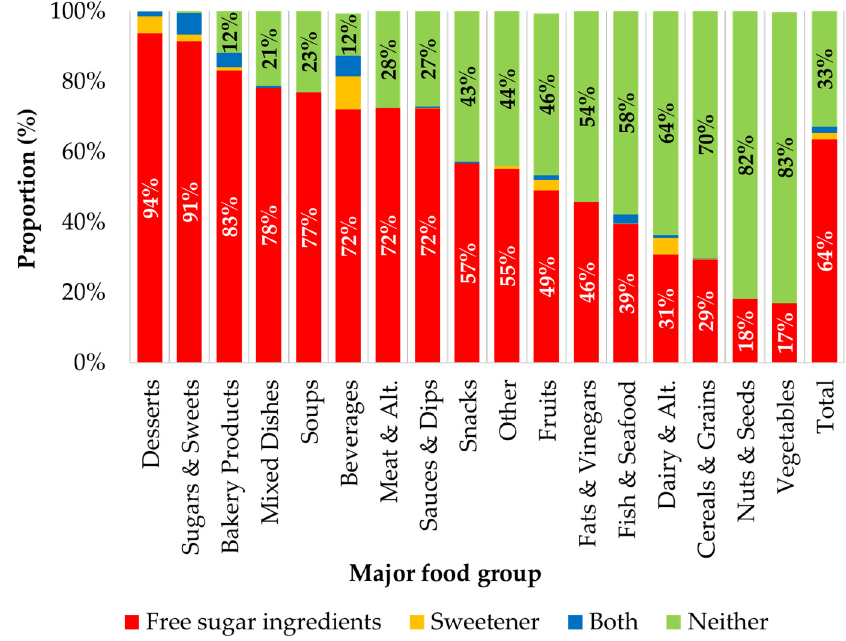
Figure 1. Proportion (%) of prepackaged foods and beverages containing free sugar ingredients,